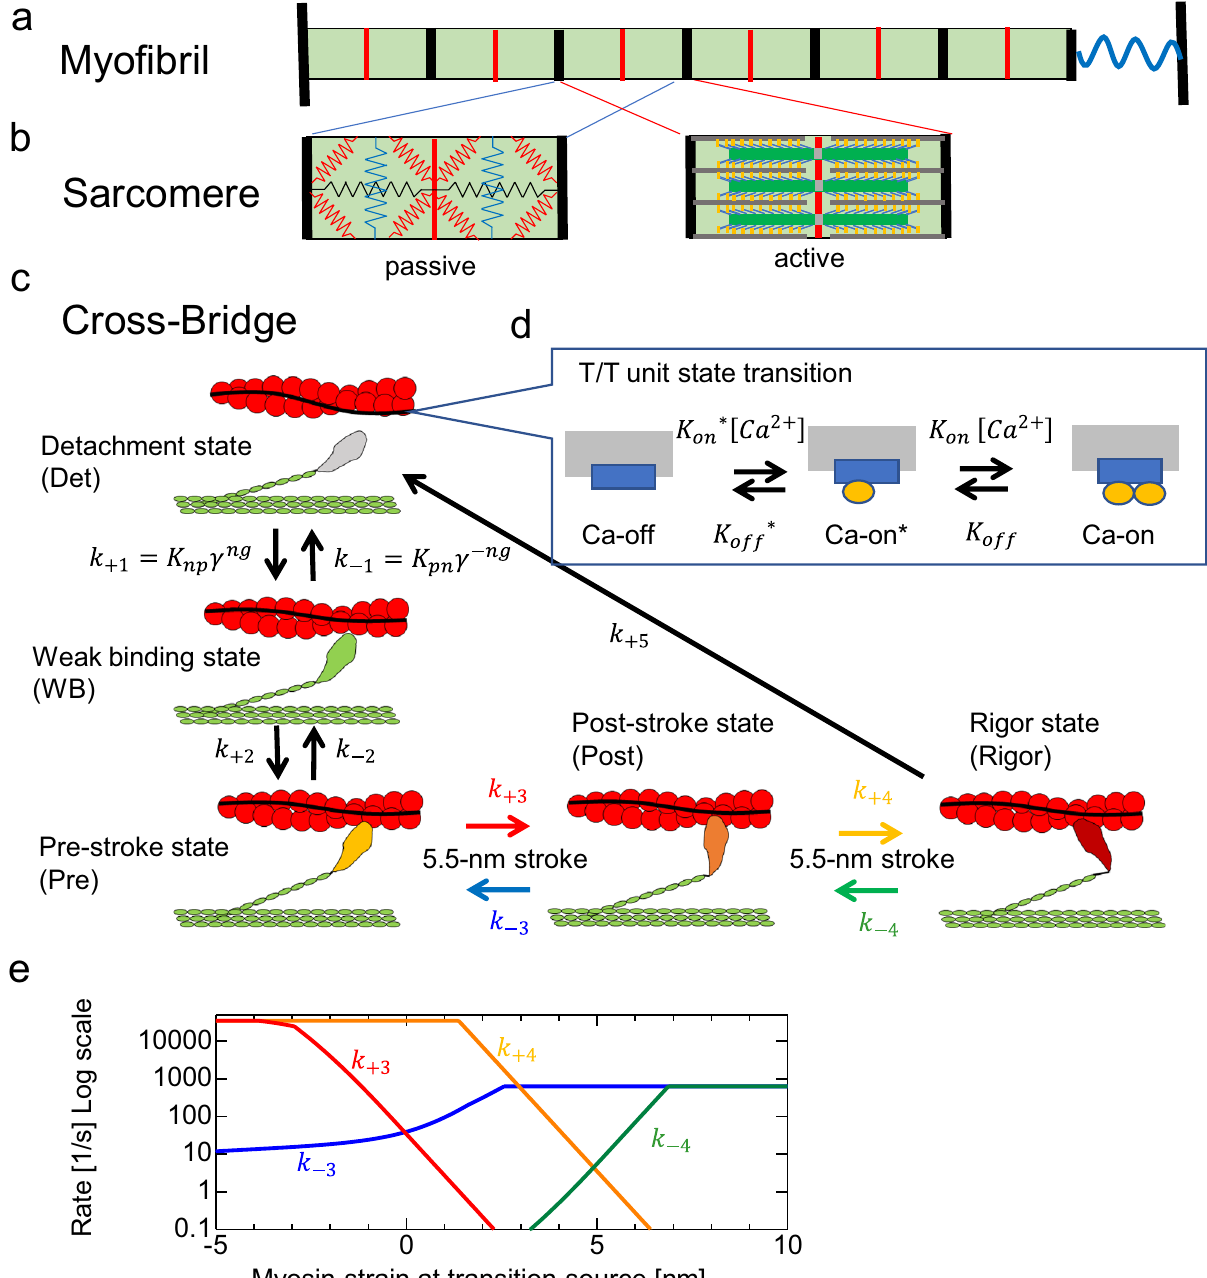
Figure 3. Schematic diagram of the model used to simulate HSOs. (a) Myofibril model. The black and red lines indicate the Z and M lines, respectively. The area between the black lines is a sarcomere. The wavy blue line at the right end is an elastic element. (b) Sarcomere model. The left panel shows the arrangement of elastic elements, and the right panel shows the arrangement of myosin-derived contractile elements. ( c) Stochastic state transition model of the actomyosin complex. The active tension was caused by three attached states (Pre, Post, and Rig). The transitions between the Det and WB states were influenced by the state of the T/T unit. ( d) T/T unit above the myosin head with the coefficients K np and K pn and the states of the neighboring myosin molecules determined via the cooperative factors γ ng and γ −ng ( γ = 60). Here, ng (= 0, 1, or 2) is the number of neighboring myosin heads in either the WB state or the bound states (Pre, Post, and Rig). ( e) The rate constants k + 3 , k −3 , k + 4 , and k −4 for transitions between the bound states are given as functions of the rod strain. The details are given in the